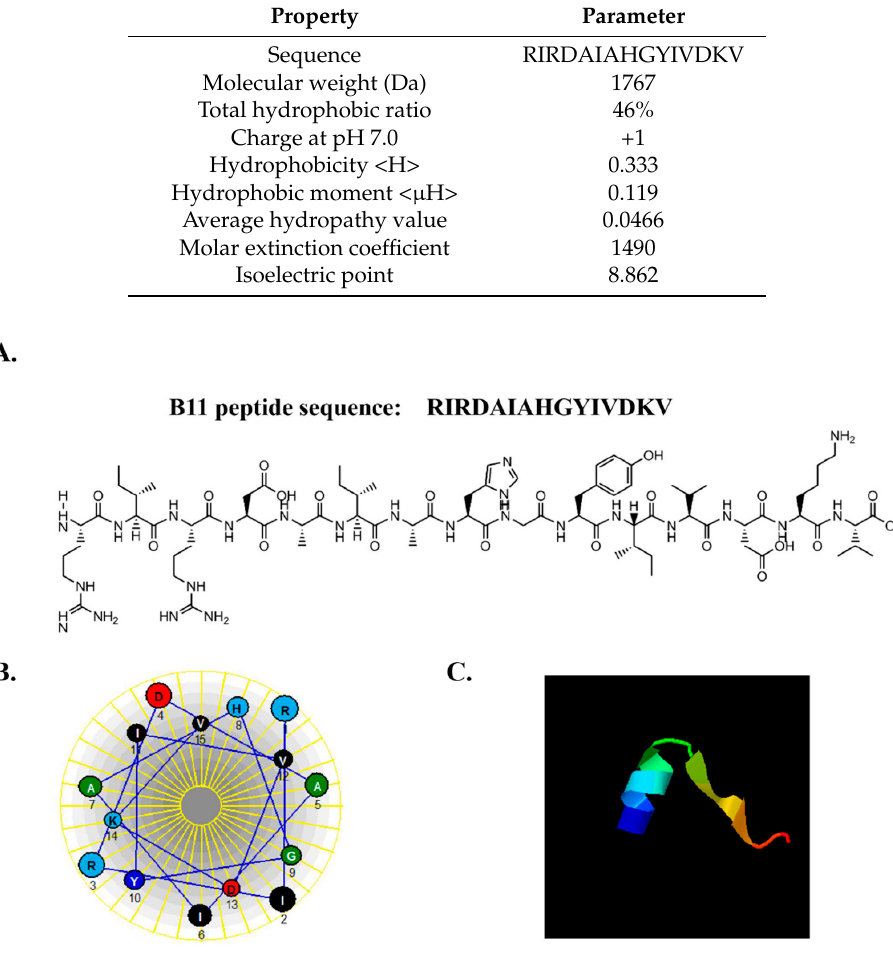
Table 1. Predicted physicochemical properties of peptide